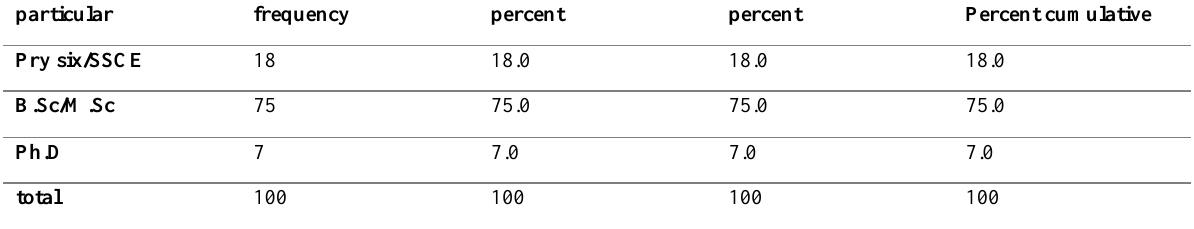
Table 5: Qualification of investment manager